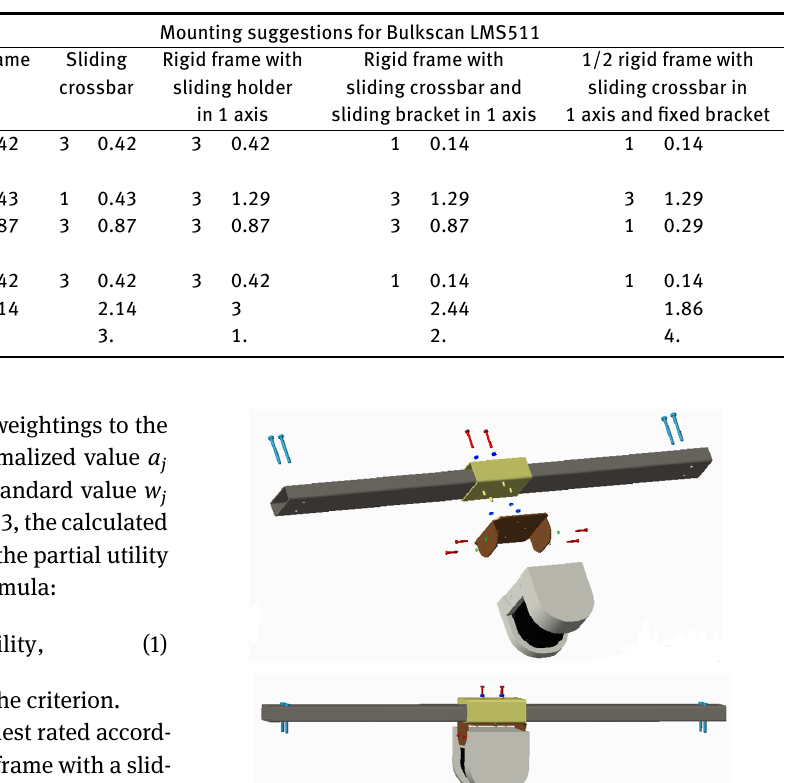
Table 3: Calculation the overall utility of variant order by index method